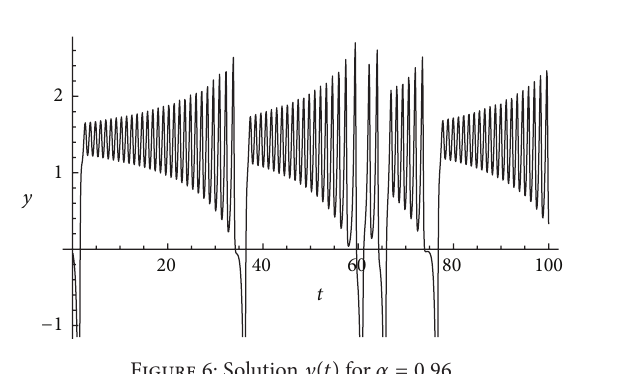
Figure 9: Phase portrait x - y 𝛼 1 = 0.88, 𝛼 2 = 𝛼 3 = 1 .